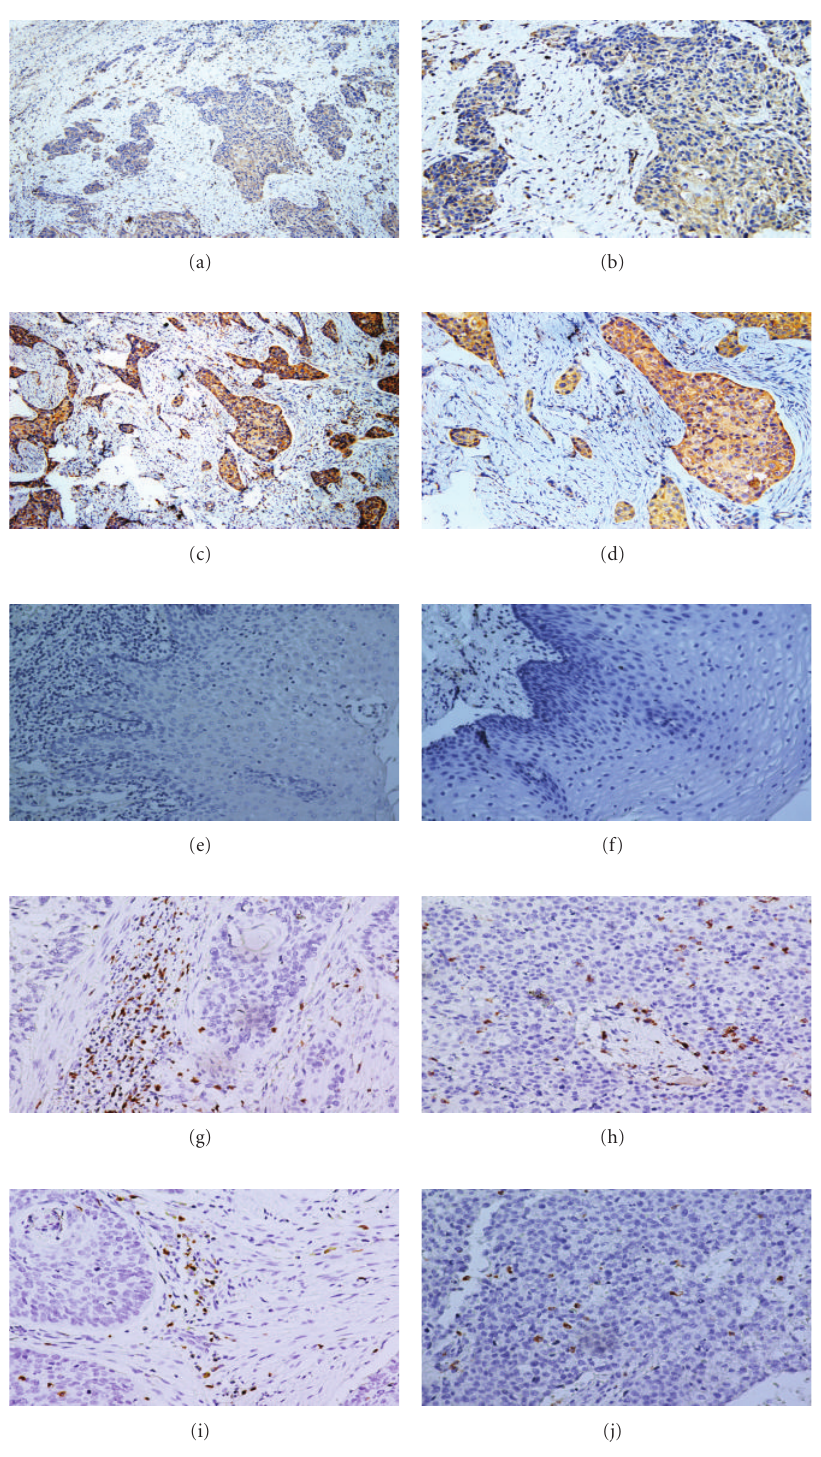
Figure 1: Expression analysis of IDO protein in ESCC by immunohistochemistry and representative immunohistochemical staining for CD8 + TILs. (a, b) Example of IDO-low expression. (c, d) Example of IDO-high expression. (e, f) Staining of IDO in normal esophageal epithelial tissue, (e) absent; (f) weak. (g) Example of stromal CD8 + TIL staining in IDO-low expression tumor tissue. (h) Example of intraepithelial CD8 + TIL staining in IDO-low expression tumor tissue. (i) Example of stromal CD8 + TIL staining in IDO-high expression tumor tissue. (j) Example of intraepithelial CD8 + TIL staining in IDO-high expression tumor tissue (original magnification, (a) and (c) × 100; (b, d, e–j) ×